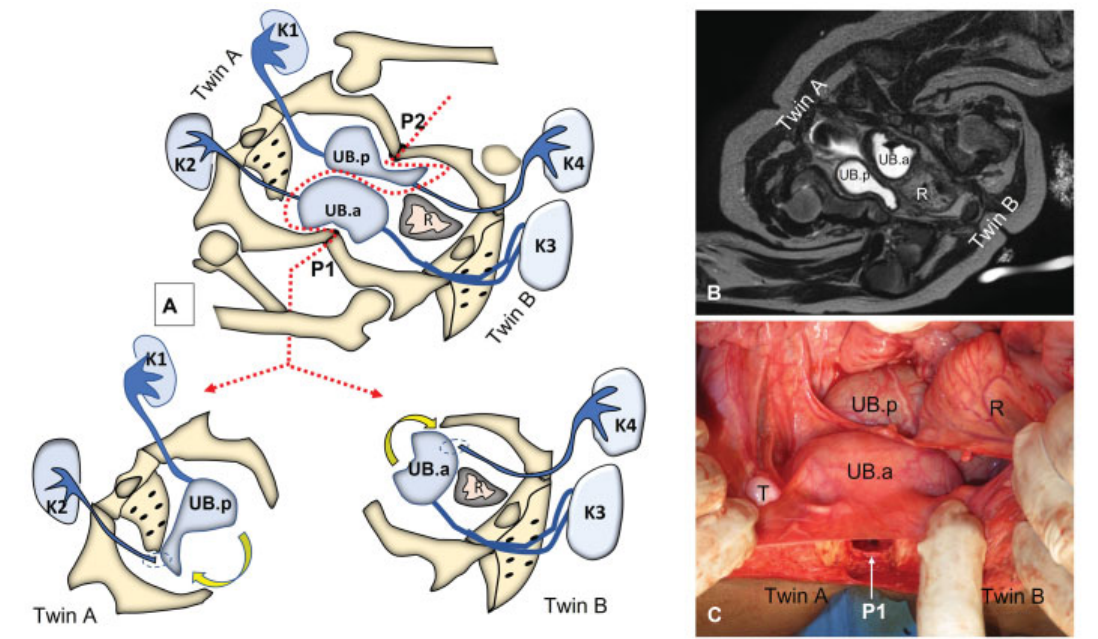
Fig. 5 Demonstrationofpelvicfusioninomphaloischiopagusconjoinedtwins.( A )Schematicdiagramfortheplanofseparation:Thedottedlinerepresents amodi fi edS-shapedplaneofseparationthatinvolvesdisarticulationoffusionbetweentwinsatbothpubicbones(P1andP2)inadditiontodisinsertionand reimplantationofoneureter foreachtwintofacilitateseparationofbothbladders.(B)AxialMRI(T2 – WI).(C)Intraoperativephotoatseparation;notewhite arrow points to disarticulation of anterior cartilaginous joint (P1) between both twins. (K1 – 4: location of the 4 kidneys in both twins; UB.a/b: both urinary bladdersanteriorandposteriorrespectively;R:rectum;T:testis).Notethattheleftkidney(K3)oftwinBwasassociatedwithduplicationoftheupperureter. MRI, magnetic resonance imaging; WI, weighted